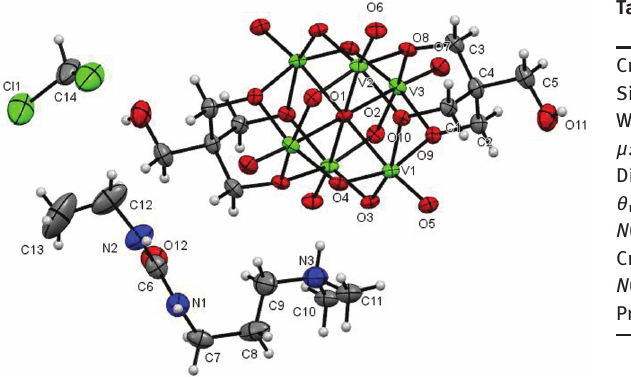
Table 1: Data collection and